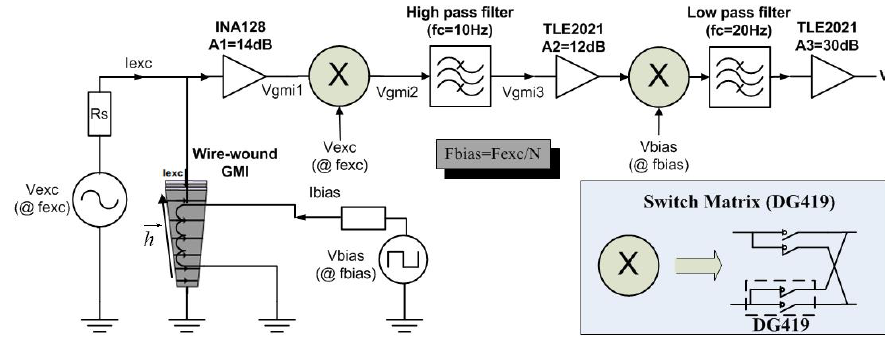
Figure 5. Signal conditioning principle.